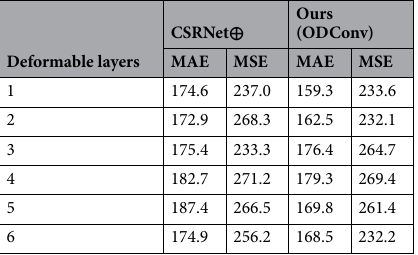
Table 3. Effects of the number of deformable layers on UCF_CC_50.